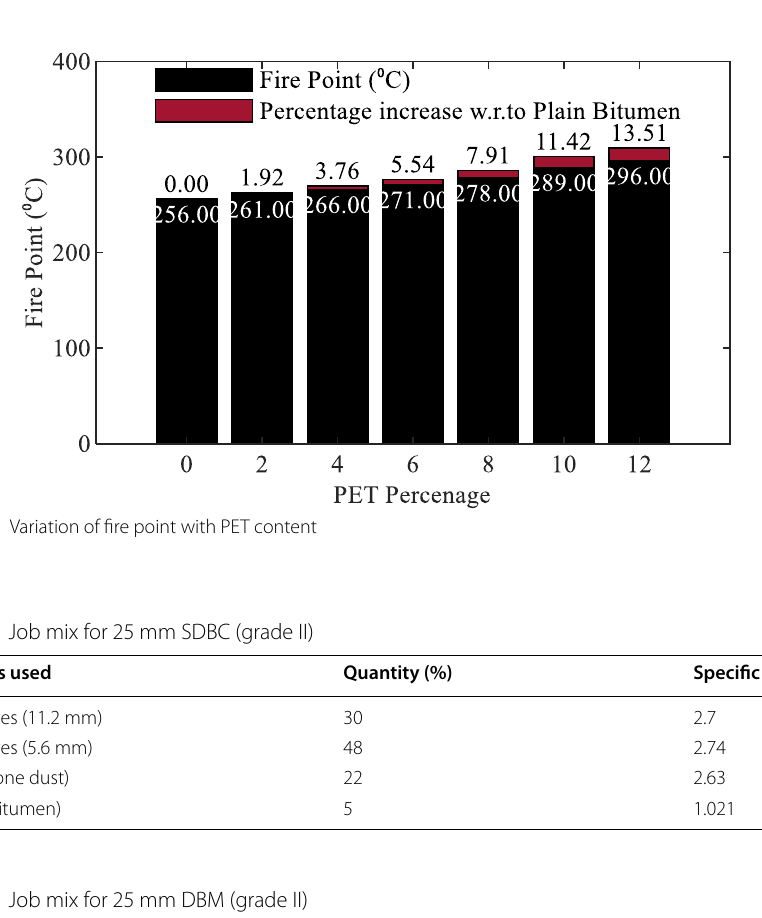
Table 3 Job mix for 25 mm DBM (grade II) Materials used Quantity (%)